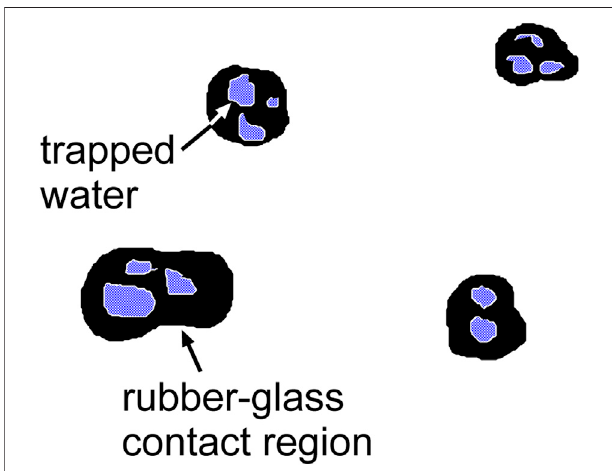
FIGURE 9 | The measured friction coef fi cient for compound C on smooth silica glass plates as a function of the logarithm of the sliding speed. The rubber surface was roughened by sand paper. The squares are for dry surfaces and the stars in water. The red symbols are the measured friction coef fi cient on a glass surface cleaned by ultrasound in water. The green symbols was obtained on the same type of glass plate cleaned in the same way and then covered by an inert thin fi lm using Rain X. The nominal contact pressure p (cid:1) 0.05 MPa and the temperature T (cid:1) 17 ° C.